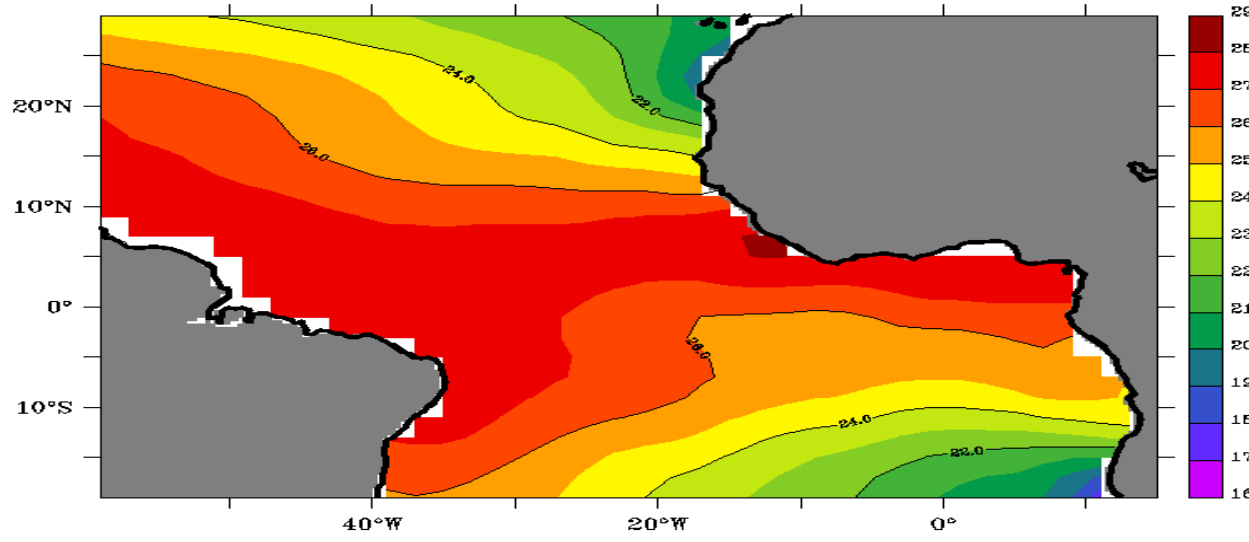
Fig. 1. 40-year (1964–2003) SST yearly climatology ( ◦ C) (from Servain’s data set: http://iridl.ldeo.columbia.edu/SOURCES/.SERVAIN/). Also according to Servain (1991), the northern limit of NB (28 ◦ N) and southern limit of SB (20 ◦ S) are chosen in order to preserve equilibrium between the annual thermal changes of both hemispheric basins. The IHSST-mode index is cal- culated by doing the arithmetic difference between the nor- malized anomalies averaged over NB minus the normalized anomalies averaged over